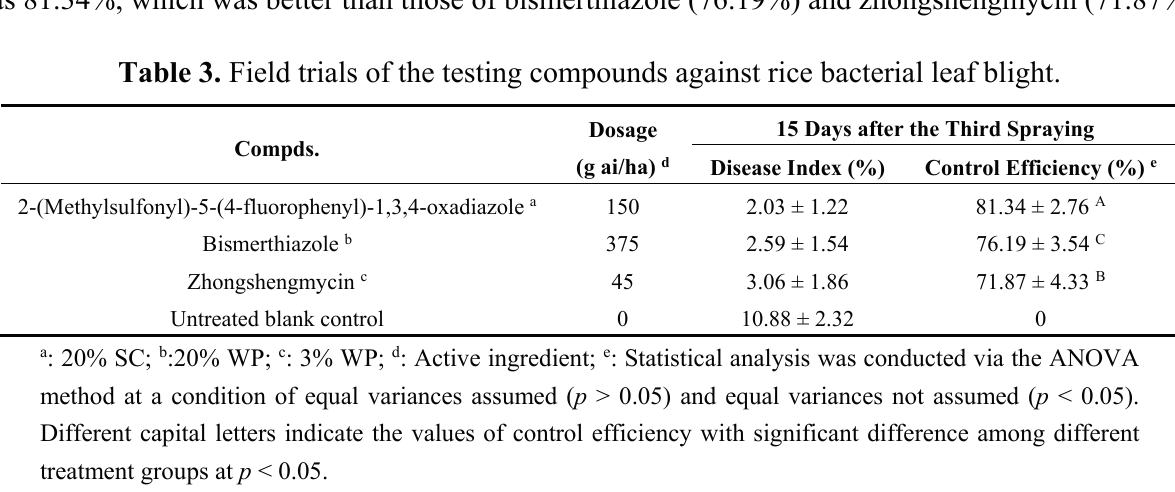
15 Days after Spraying 28 Days after Spraying Disease Index Disease Curative (%) Index (%) Activity (%) c